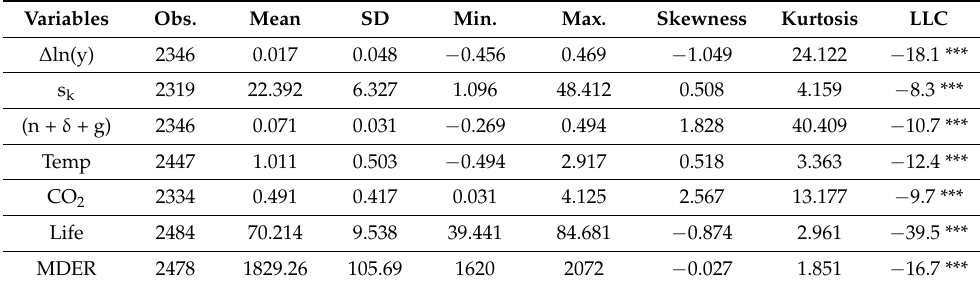
Table A1. Descriptive statistics of examined variables.